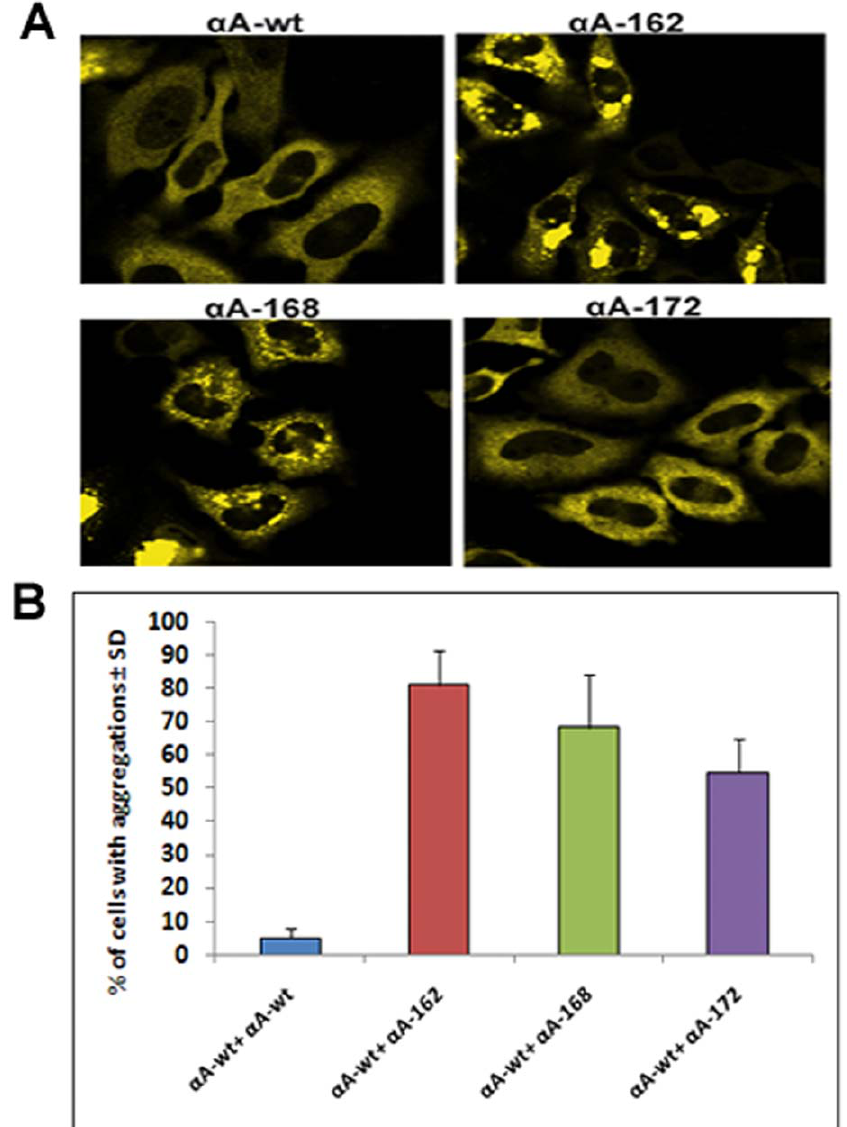
Figure 3. Co-expression of CFP-tagged a A-Crystallin wild-type with YFP-tagged a A-Crystallin wild-type and truncated constructs. A: LSM confocal images of HeLa cells . Cells co-transfected with CFP a Awt with YFP a Awt and with each of the YFP-C-terminal truncated a